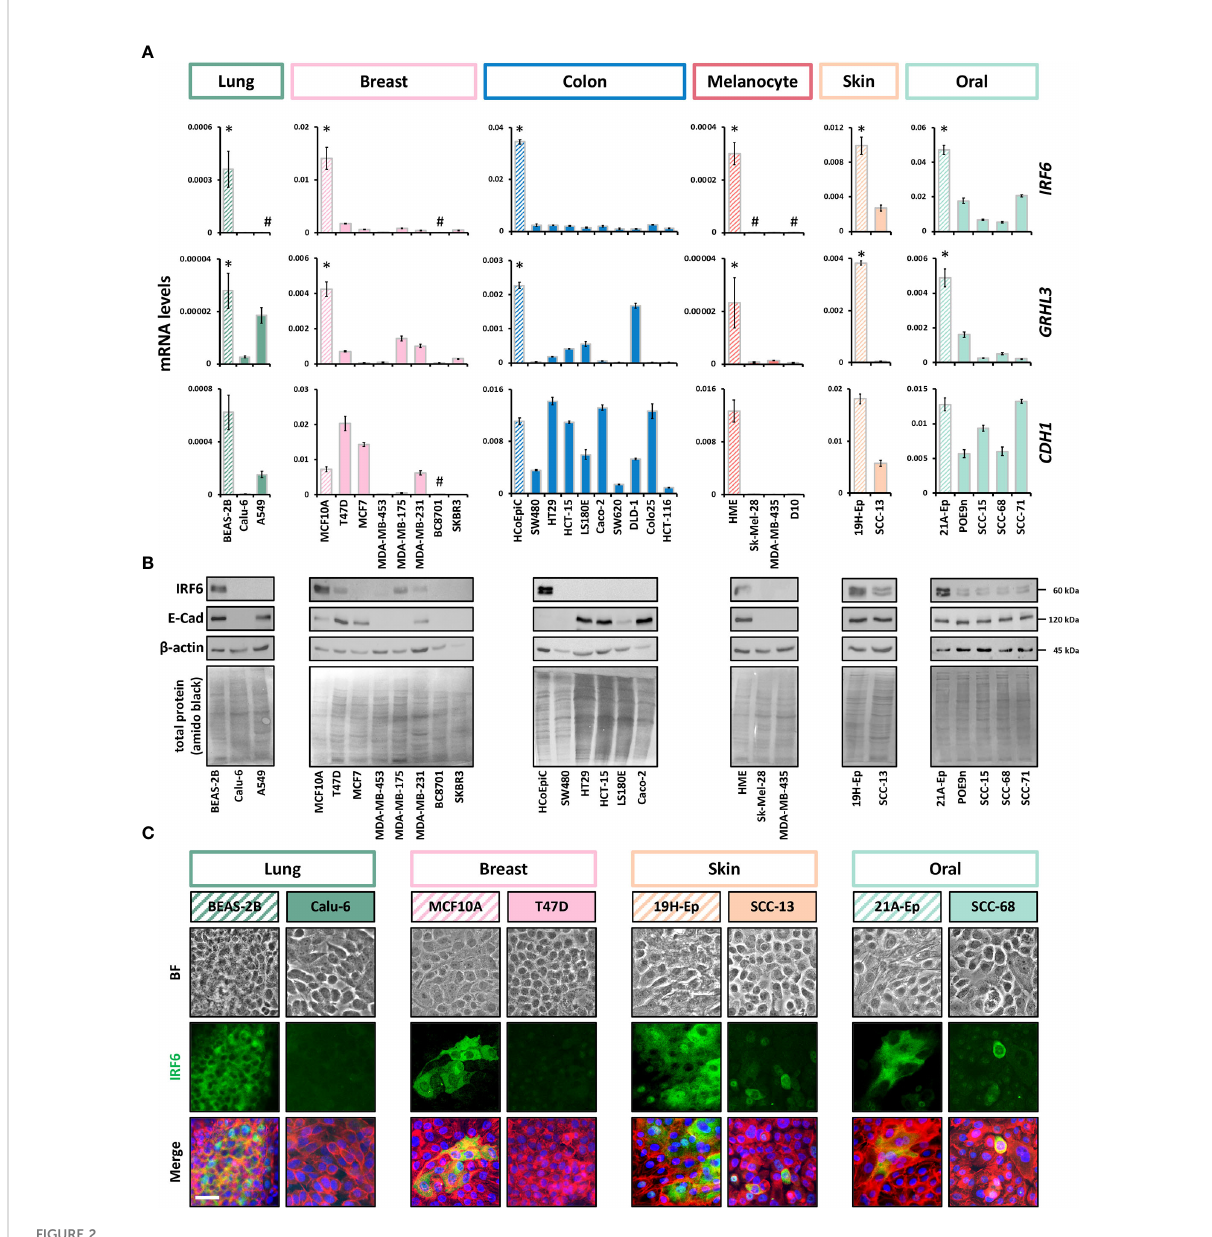
FIGURE 2 IRF6 and GRHL3 downregulation in cancer cell lines (A) Panels of cancer cell lines and corresponding normal cells (striped boxes) were screened for IRF6 , GRHL3 , and CDH1 . Note that RNA was extracted from all cell cultures at a cell density of approximately 70% con fl uency kDa, kilo Daltons. * p < 0.05 control vs. cancer cell lines; # not detectable (c T > 32). HME: human melanocytes. (B) Immunoblots for IRF6 and E- Cadherin in a subset of the analyzed cancer cell lines and controls. Full-length blots are shown in Supplementary Figure 6. HME: human melanocytes. (C) Bright fi eld (BF) pictures, IRF6 staining, as well as the merge of IRF6 (green) with actin (red) and cell nuclei (blue) is shown for breast and lung cancer, skin and oral SCC samples and their corresponding normal controls. Note that IRF6 is predominantly expressed in the cytoplasm of the various cells. Scale bar: 25